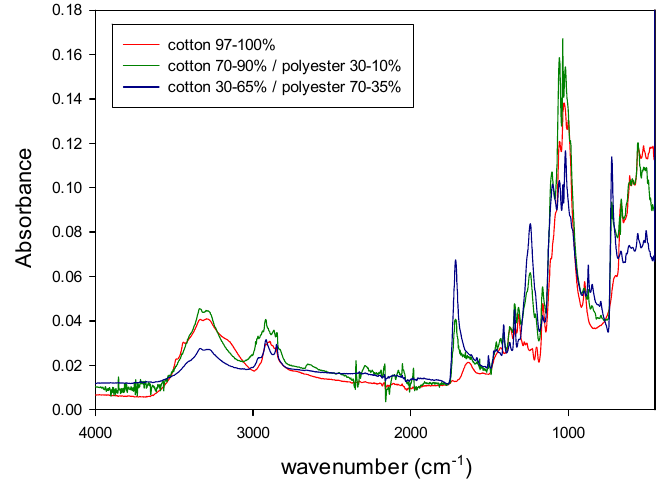
Figure 9. MIR spectra of binary mixtures of cotton/polyester.